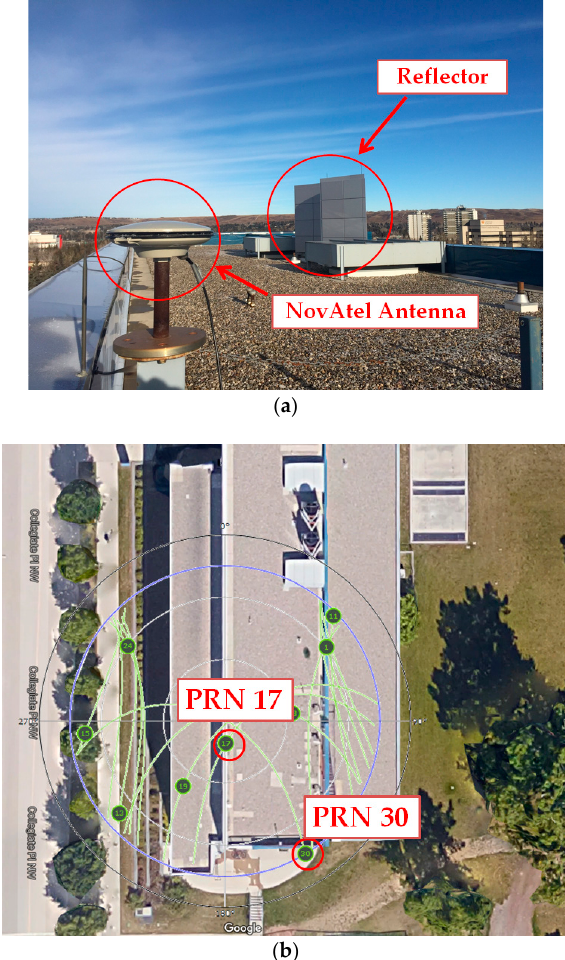
Figure 7. ( a ) Multipath data collection for static test scenario; ( b ) GPS satellites skyplot for static data collection.